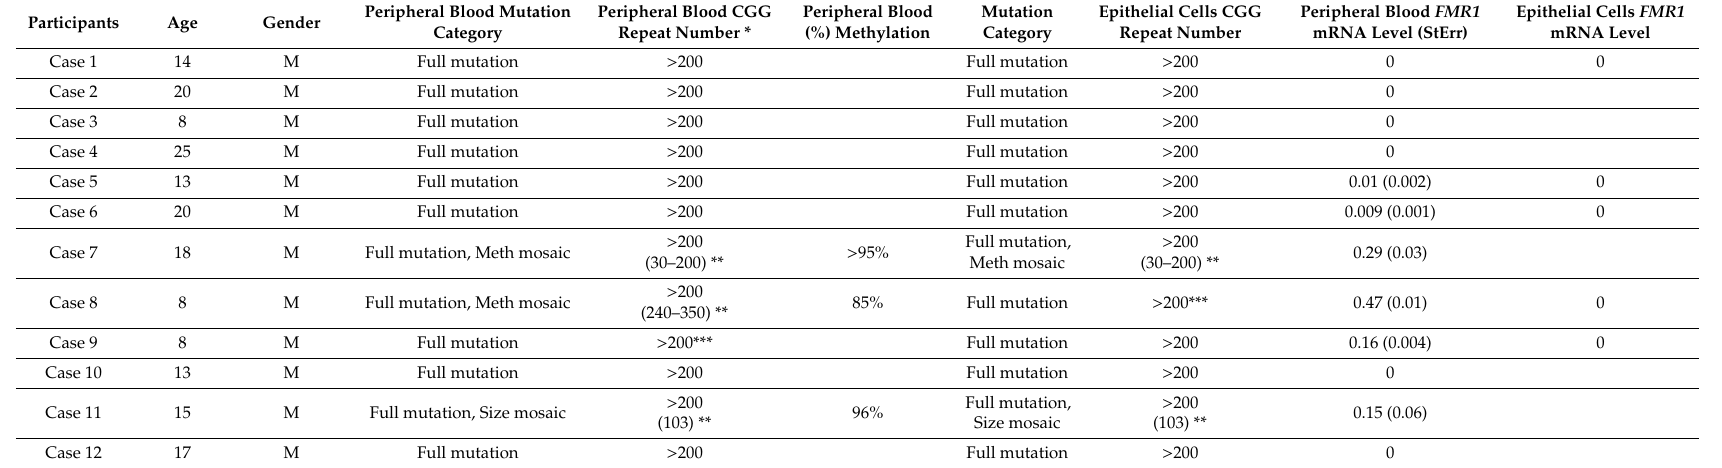
Table 1. Demographic and molecular information for participants included in the